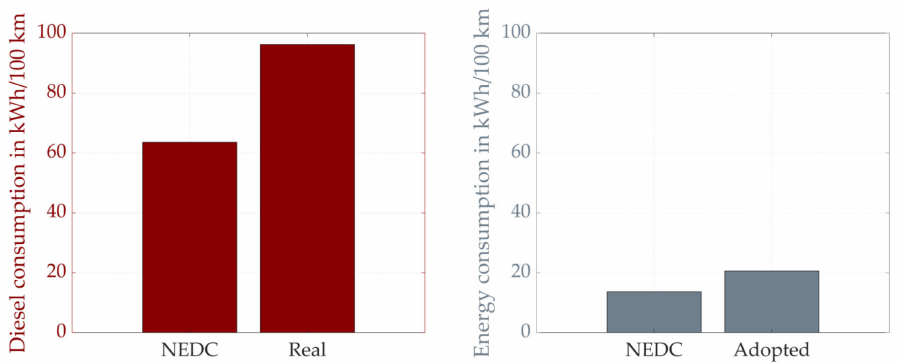
Figure 4. Comparison between the real vehicle fuel consumption and the average manufacturer’s consumption declaration, and the corresponding electricity consumption for an